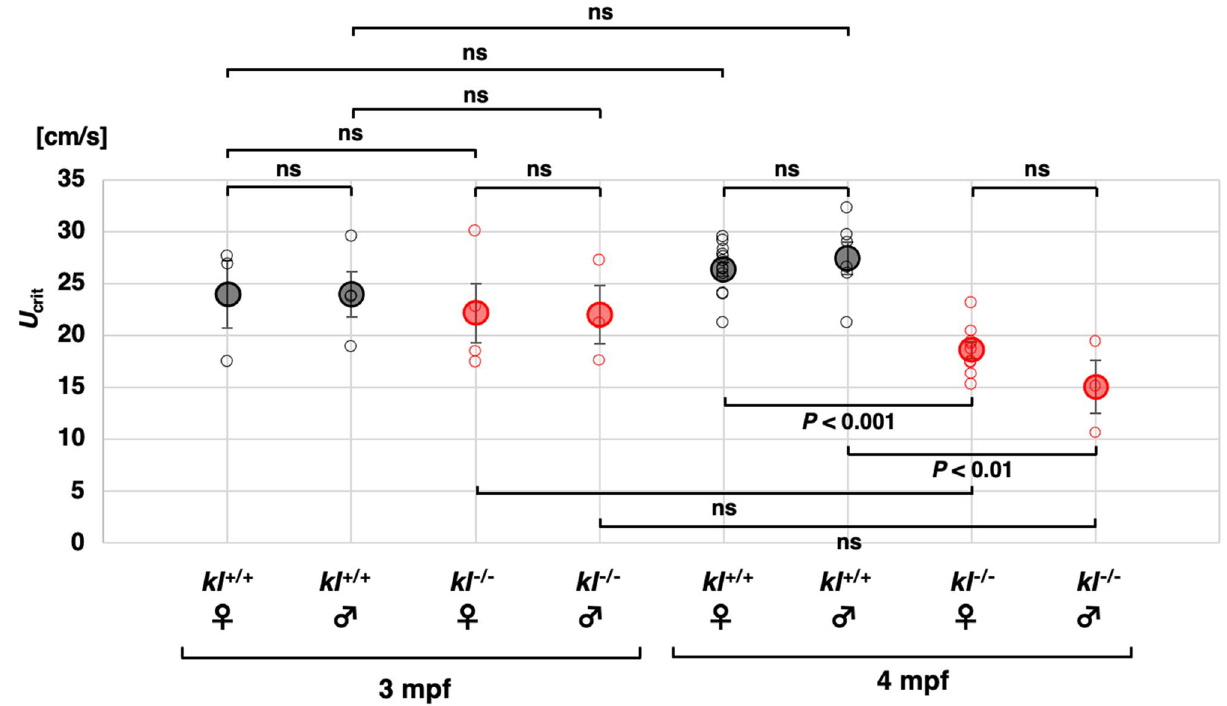
Figure 3. Swimming performance in kl mutants declines by 4 mpf. The critical swimming speed ( U crit ) of 3 mpf and 4 mpf zebrafish were measured using a swimmill. The kl +/+ female (n = 3), kl +/+ male (n = 4), kl −/− female (n = 4) and kl −/− male (n = 3) were assayed at 3 mpf. The kl +/+ female (n = 13), kl +/+ male (n = 9), kl −/− female (n = 6) and kl −/− male (n = 3) were assayed at 4 mpf. Open black ( kl +/+ ) and red ( kl −/− ) circles indicate U crit of individual samples. Closed black ( kl +/+ ) and red ( kl −/− ) circles with error bars indicate mean ±